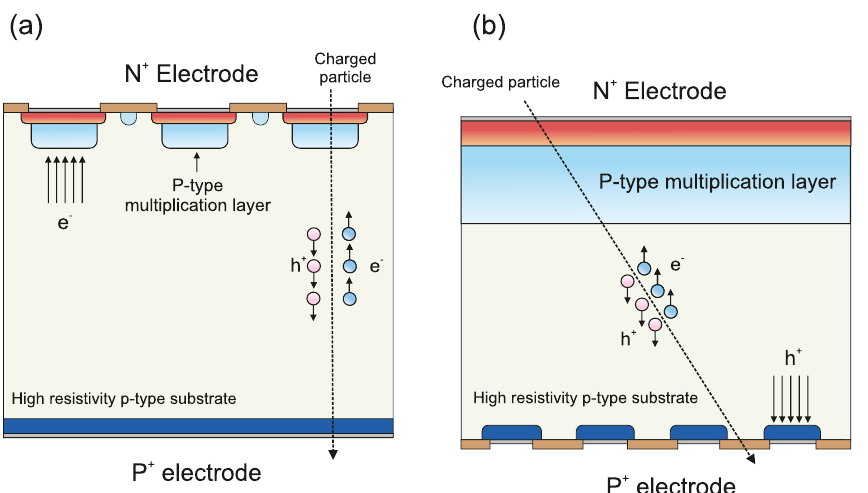
Figure 1. Comparison between ( a ) LGAD and ( b ) iLGAD structures. In the LGAD, the multiplication region is segmented on the n + electrode side, collecting electrons. In the iLGAD, p + electrode is segmented on the ohmic side, collecting holes. A 100 % fill factor is achieved with the iLGAD. The sketch is not to